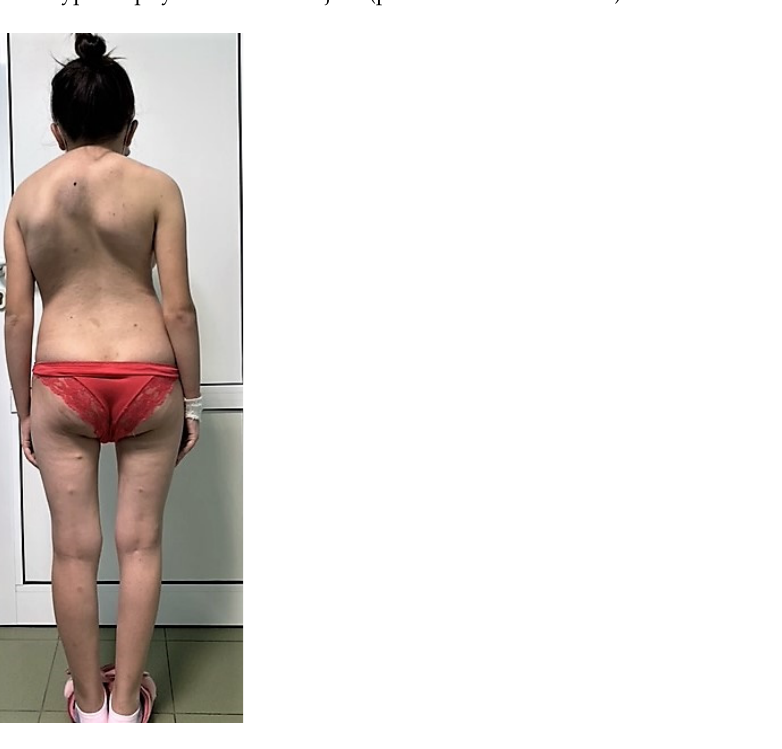
Figure 2. Short stature for age, subcutaneous nodules, and kyphoscoliosis.